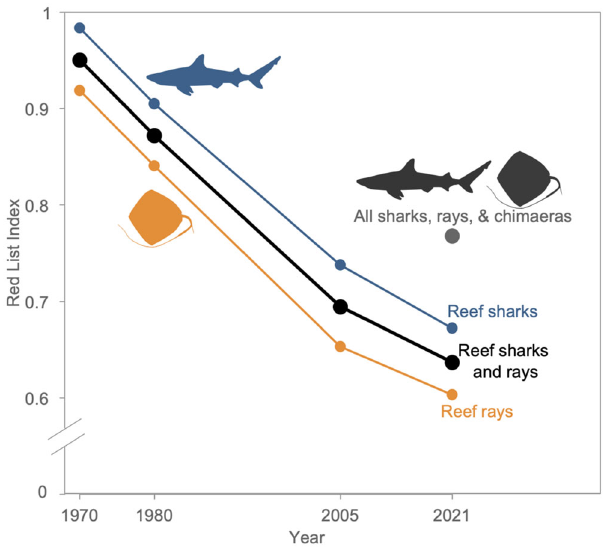
d , h histogramsrepresentthenumberofgridcellscontainingdifferentpercentages of threatened species.